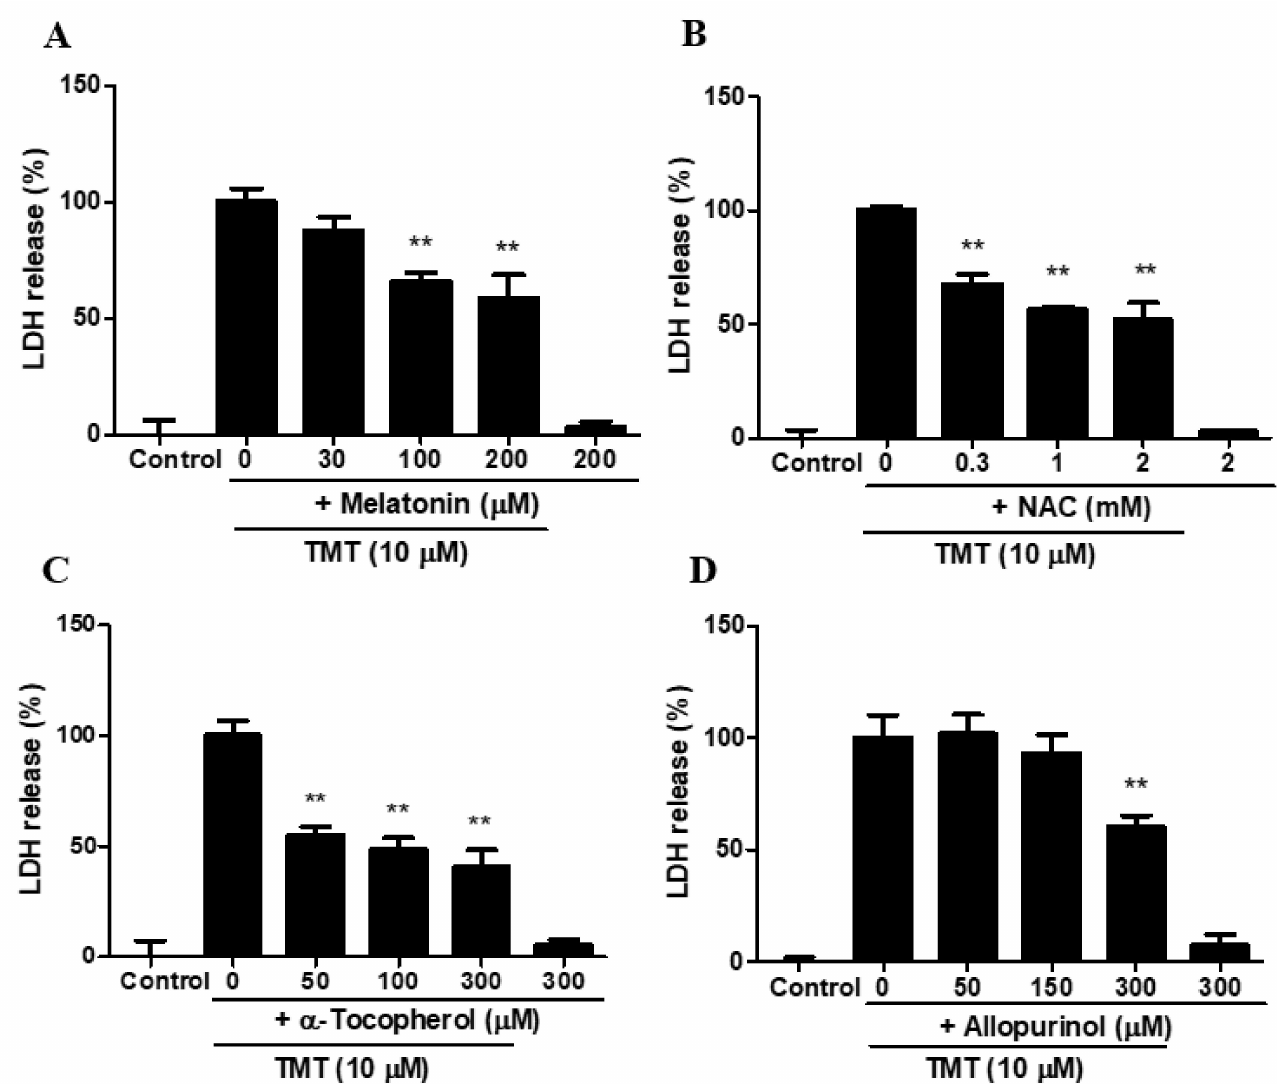
Figure 3. Protective effects of various antioxidants melatonin ( A ), N-acetylcysteine (NAC) ( B ), α -tocopherol ( C ), and allop- urinol ( D ) against TMT-induced neurotoxicity in SH-SY5Y cells. Cytotoxicity was evaluated using a lactate dehydrogenase (LDH) release assay. ** p < 0.01 compared to the 10- µ M TMT-treated group ( n = 4). Experiments were performed at least three times, with similar